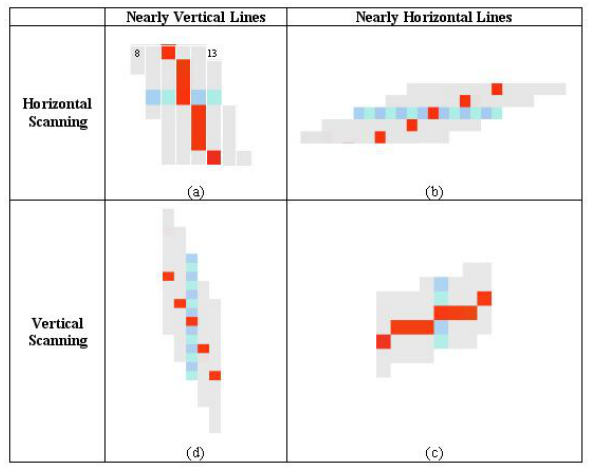
Figure 3. Determining red pixels by using horizontal and vertical scanning